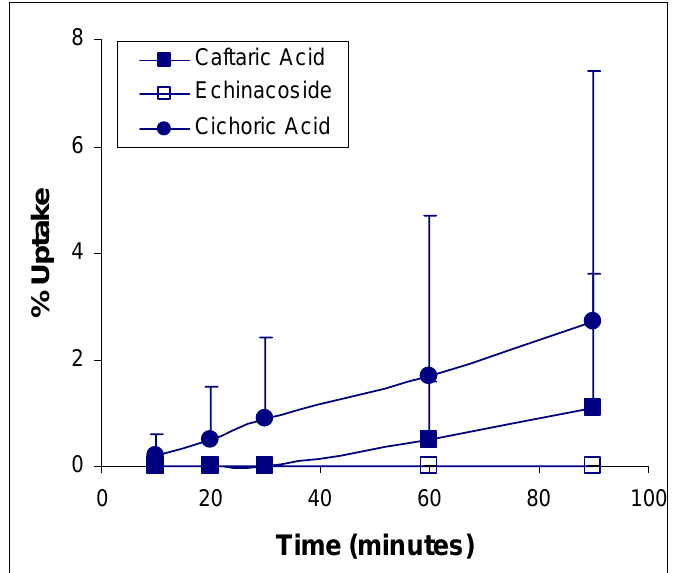
Figure 4: Caffeic acid derivative transport kinetics in Caco-2 monolayers. Values are means ± sd for 3 - 5